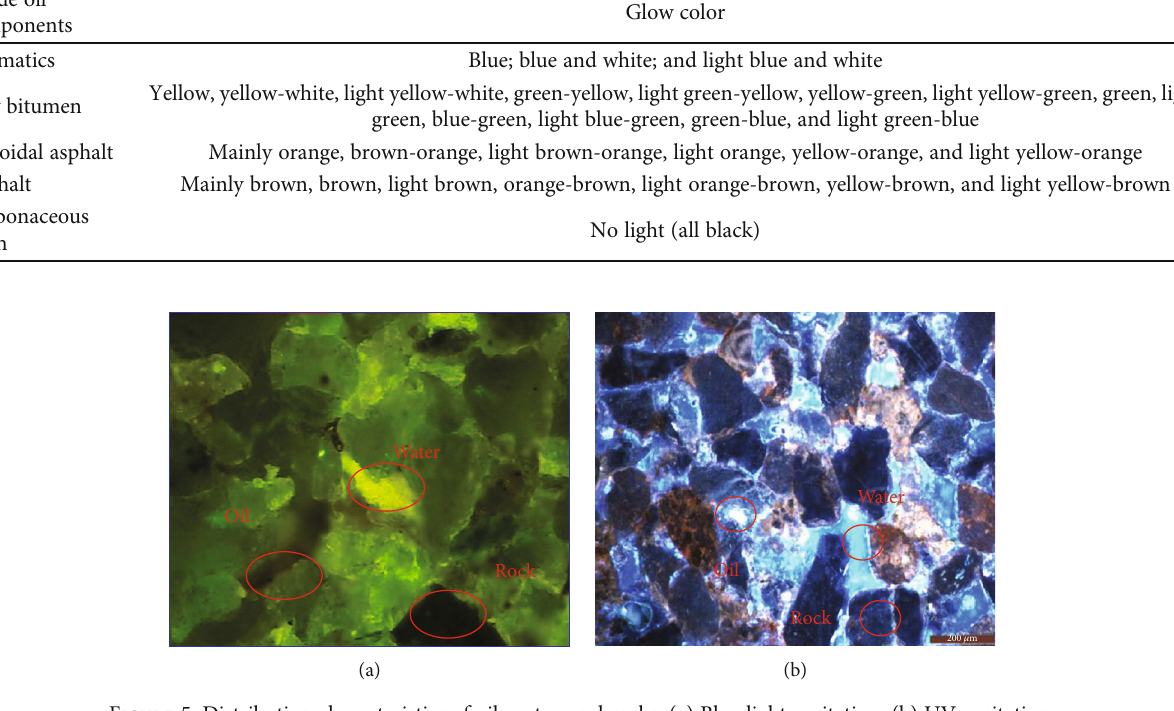
Figure 5: Distribution characteristics of oil, water, and rocks. (a) Blue light excitation. (b) UV